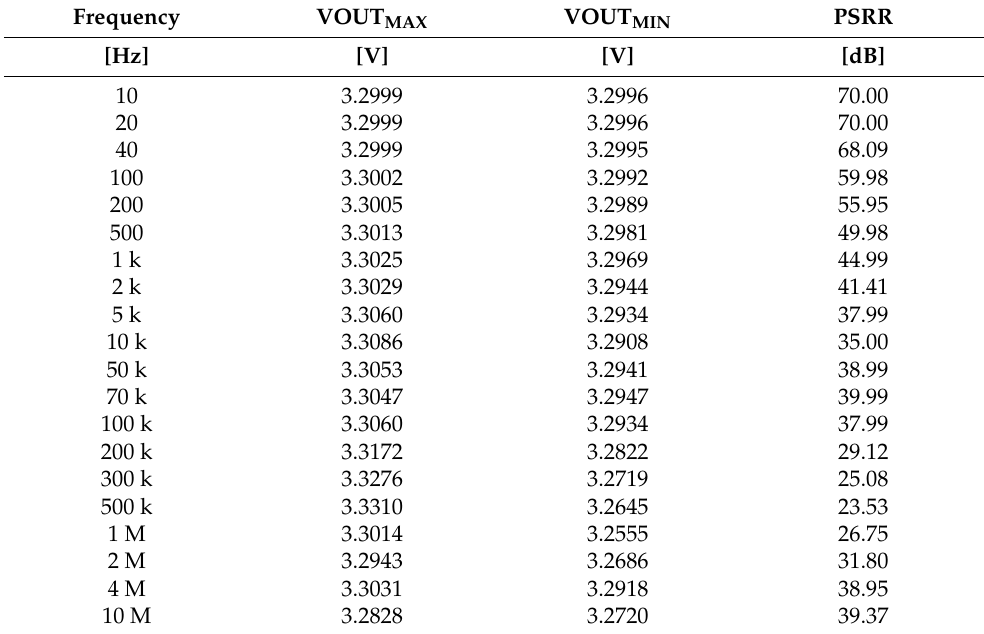
Table 1. Simulated new PSRR vs. frequency.